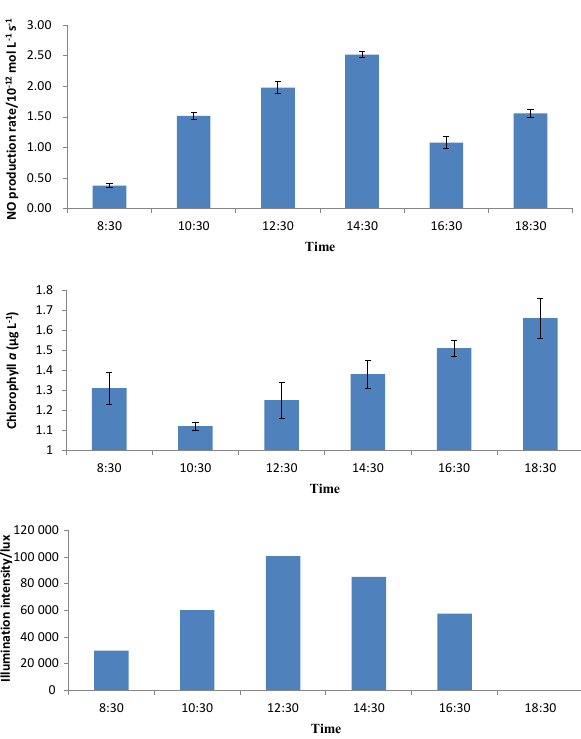
Figure 8. The variation in NO production rates, chlorophyll a con- centrations, and sunlight intensities in the incubation experiments using Qingdao coastal